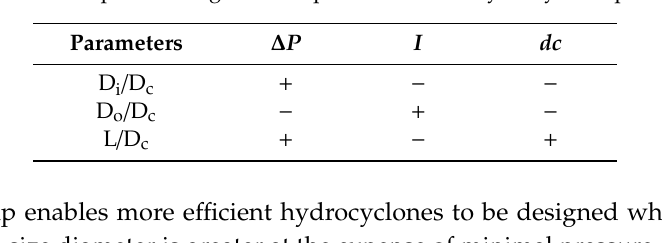
Table 8. Relationship between geometric parameters and hydrocyclone